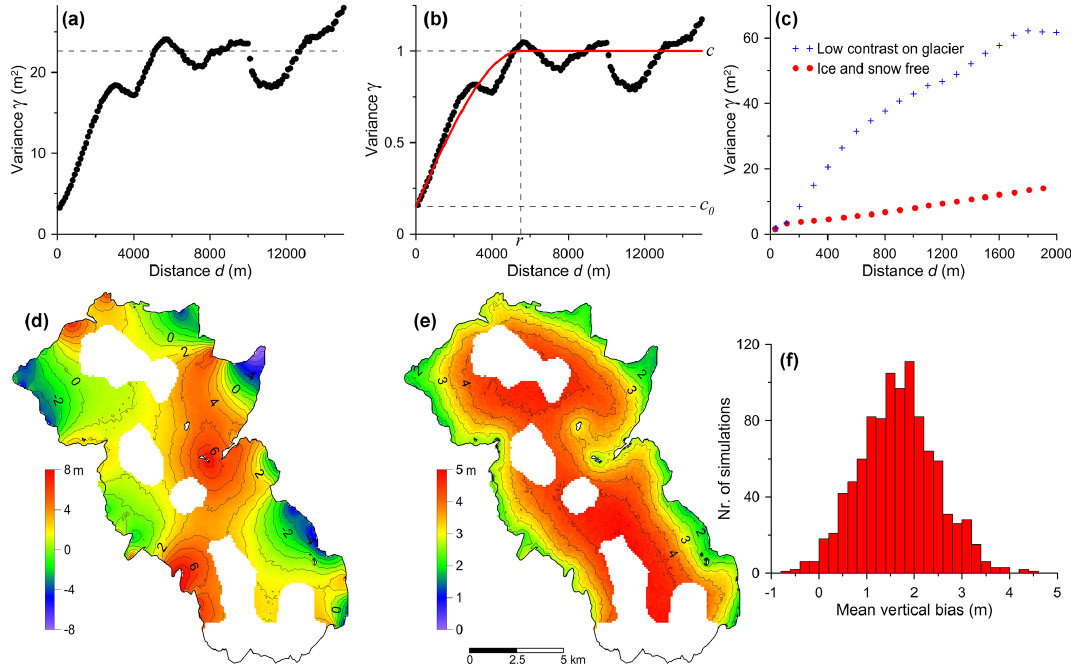
Figure 4. The semivariograms of the 1946 DEM error before (a) and after (b) nscoring the data. The DEM error data are derived from the elevation difference compared to the lidar DEM in ice- and snow-free areas. Outliers in the elevation difference and areas with slope>20 ◦ were also masked out. The spherical semivariogram model (red line) used in the SGSim and the parameters defining it ( c , c 0 and r) are shown in (b) . Graph (c) shows comparison between semivariograms for the deduced error (same as in (a) ) and the difference compared to the lidar DEM in low-contrast areas within the glacier. (d) – (f) show the results of the SGSim for the 1946 glacier DEM. Images (d) and (e) , respectively, show the mean and standard deviation of 1000 simulations at each 100m × 100m pixel. Graph (f) shows histogram (0.2m bins) of the mean vertical bias values of the glacier DEM deduced from each